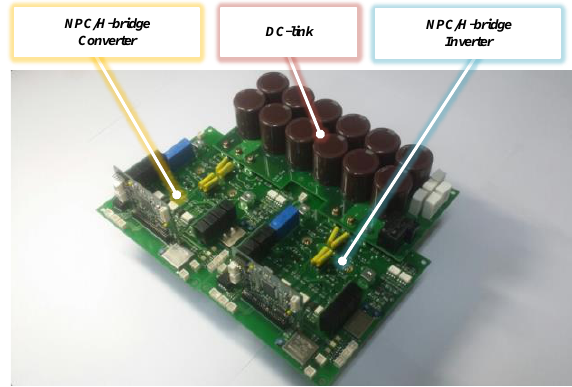
Figure 25. Experimental setup 3 of the one-stack NPC/H-bridge. Electronics 2018 , 7 , x FOR PEER REVIEW